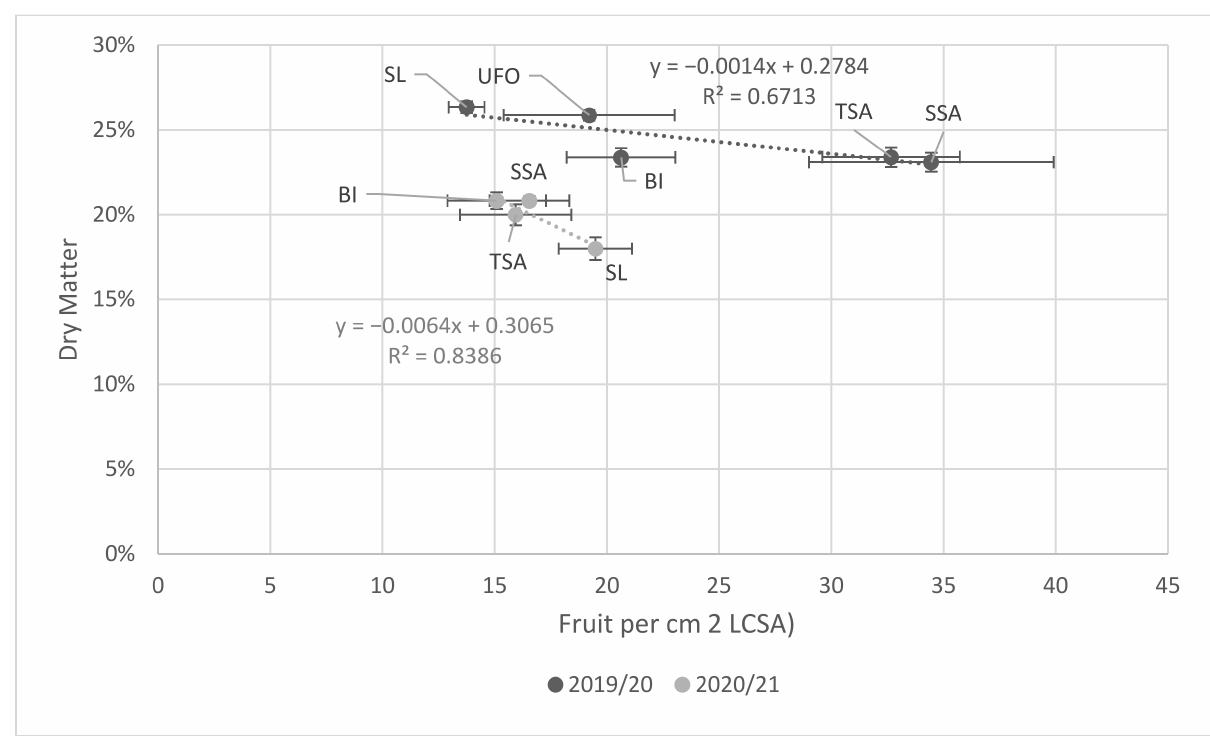
Figure 5. Correlation between crop load and fruit DMC of sweet cherry cultivar ‘Kordia’ across different training systems and seasons. Error bars represent one standard error for each training system and n = 6 for each system in a season.